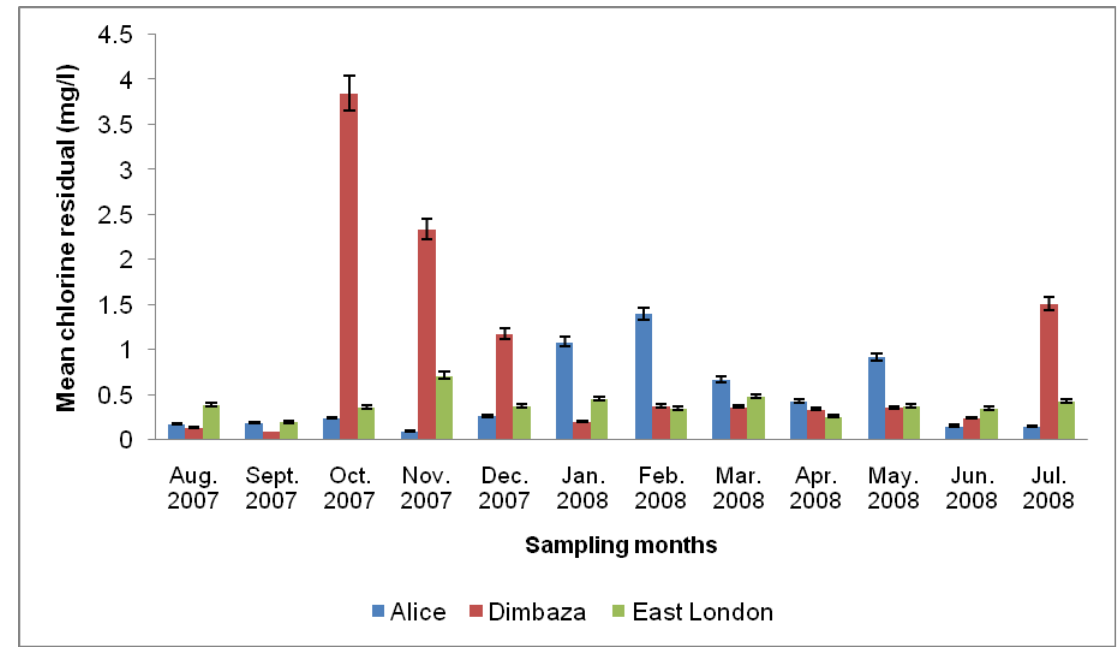
Figure 1. Chlorine residual regime of the final treated effluents from the three wastewater treatment plants